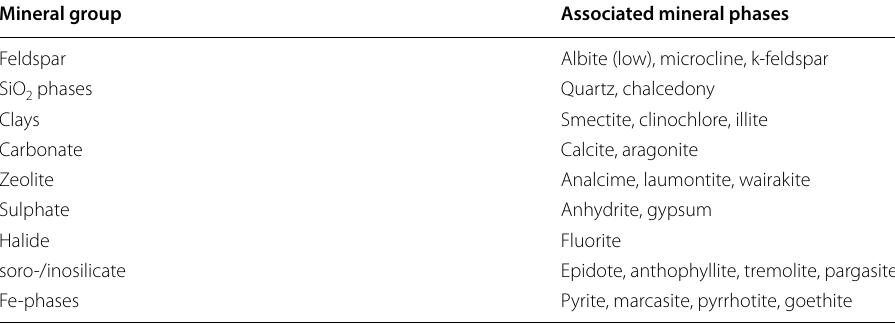
Table 2 Mineral phases contained in the basalt-specific mineral set devised and used in this